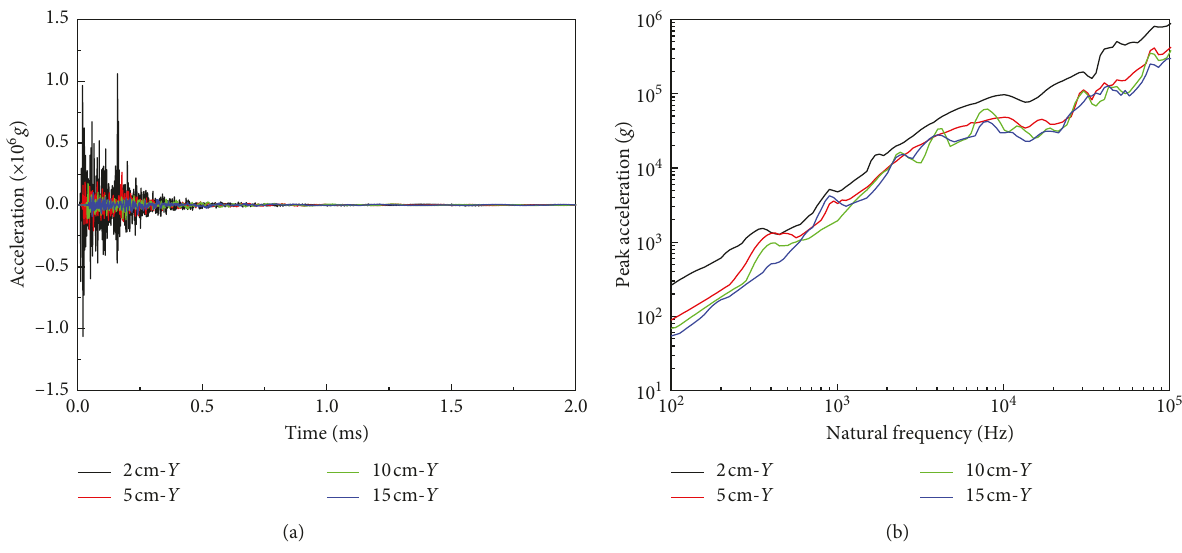
Figure 29: Separation shock in the Y direction at four different locations. (a) Acceleration history. (b)